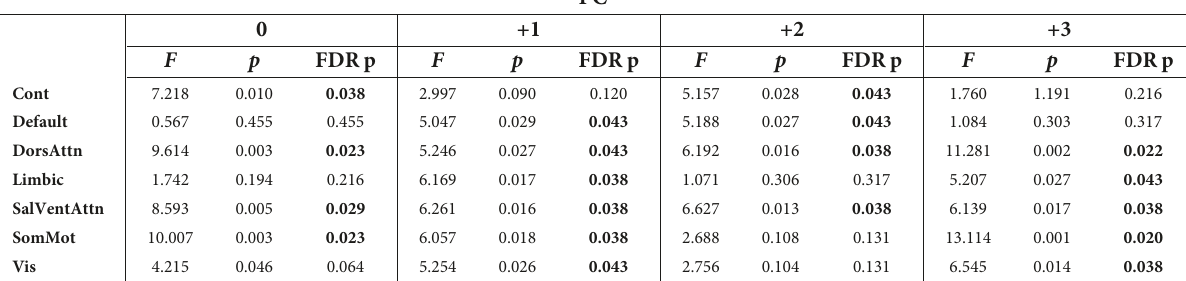
Figure and Supplementary Table 4 ) over time. TABLE 1 Results from the analysis of covariance (ANCOVA) computed at the community level on participation coefficient (PC) values per time point across groups (patients and controls) when pain was delivered to the diseased joint in patients and corresponding site in